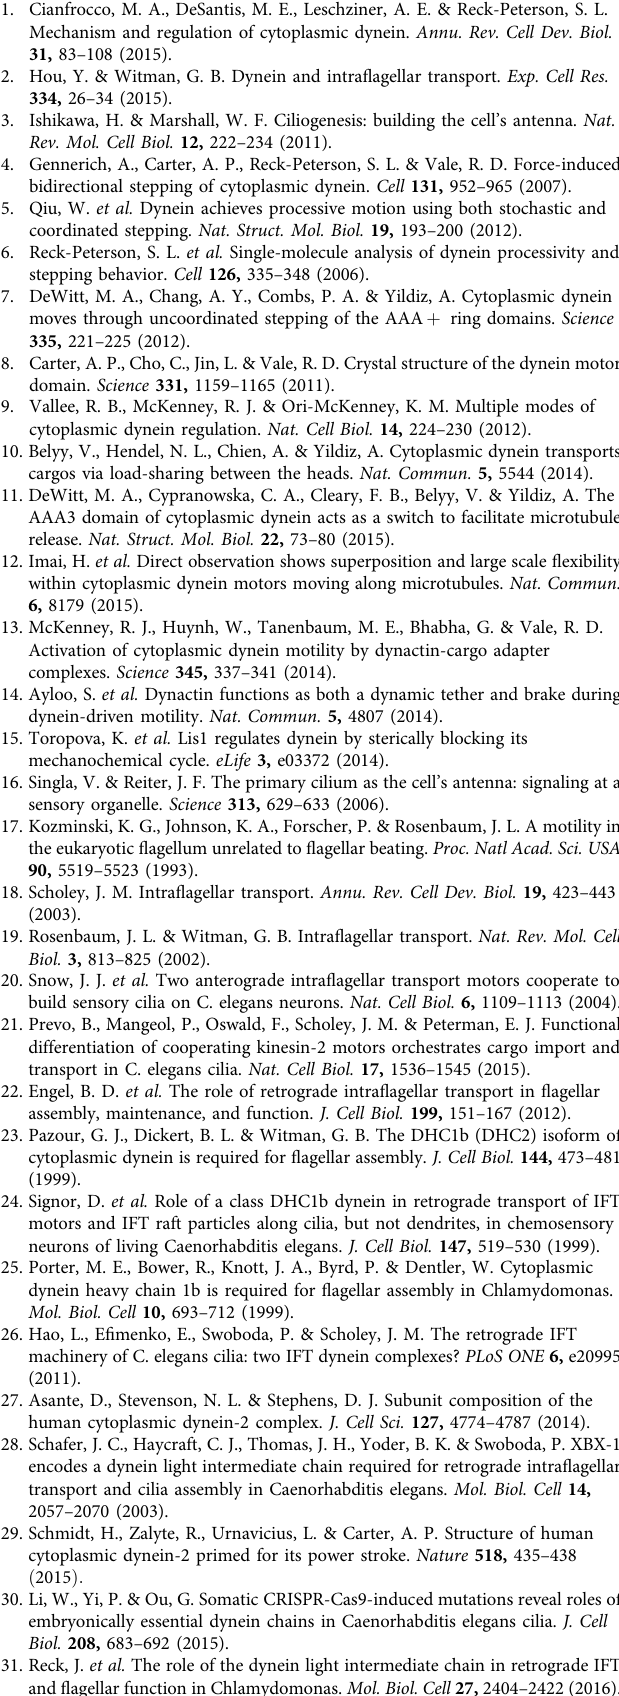
Table 1. Most strains were constructed using MosSCI 21,39 . The gene of interest, including regions up- and downstream to the neighbouring genes, was fused to codon-optimized fluorescent protein using Gibson assembly and verified by sequencing before injection 58,59 . unc-119 animals with a Mos 1 insertion site were injected with a phasmid mix containing the gene of interest, co-injection selection markers (prab-3::mCherry, pmyo-2::mCherry and pmyo-3::mCherry) and transposase 39 . Coordinated worms lacking the mCherry signal were selected and integration of the transgene was confirmed by PCR of regions spanning outside and inside the insertion (Supplementary Table 2). Extrachromosomal array strain EJP217 was generated using microinjection of the fluorescently labelled gene of interest into the